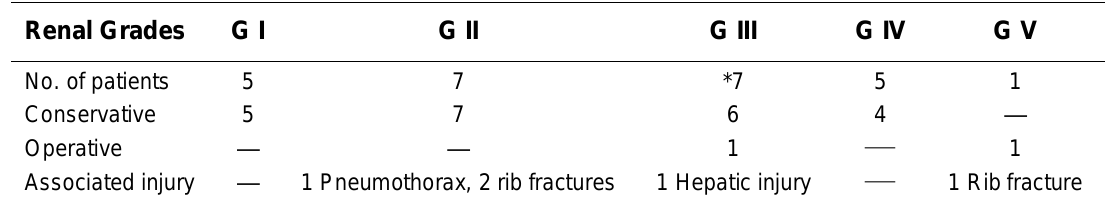
Renal Trauma Grading and Associated